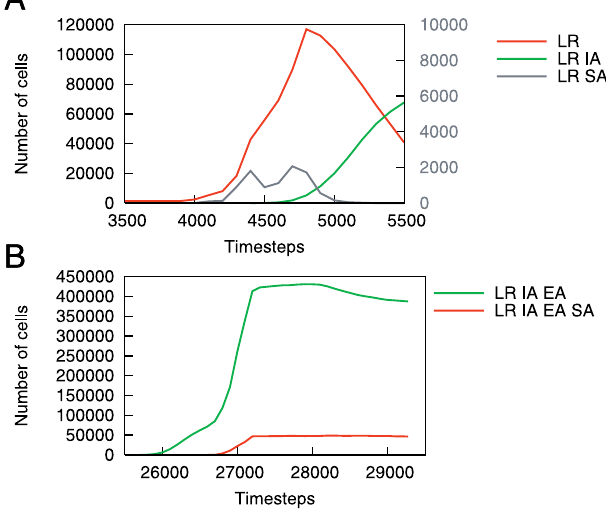
Figure 5. SA Creates a Niche for Other Cell Populations (A) A population of LR SA cells (secondary y- axis) allows the population of LR cells to proliferate. Eventually, the LR IA cells replace the LR SA cells, temporarily preventing the development of new vasculature. (B) In this case, the cells creating the blood supply have additional mutations, allowing the LR IA EA SA population to plateau rather than decline, as occurred in the case of the LR SA cells in (A). DOI: